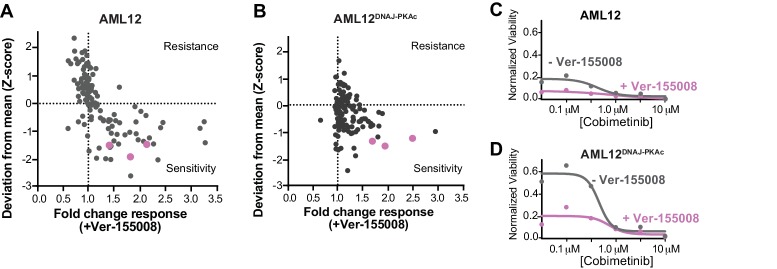
Repeat combination drug screens at lower concentrations (3 μM) of Ver-155008.(A and B) Scatterplots show relative resistance or sensitivity of (A) AML12 and (B) AML12DNAJ-PKAc cells to the combination of 125 different chemotherapeutic drugs with Ver-155008. Drug combinations in the lower right quadrant are more sensitive to drug treatment than those in the upper right quadrant. Binimetinib, cobimetinib and trametinib are highlighted (pink circles). (C and D) Analysis of (C) wildtype AML12 and (D) AML12DNAJ-PKAc cell survival: Dose-response of the drug cobimetinib alone (gray) or in combination with Ver-155008 (pink). Drug concentrations (μM) are indicated.